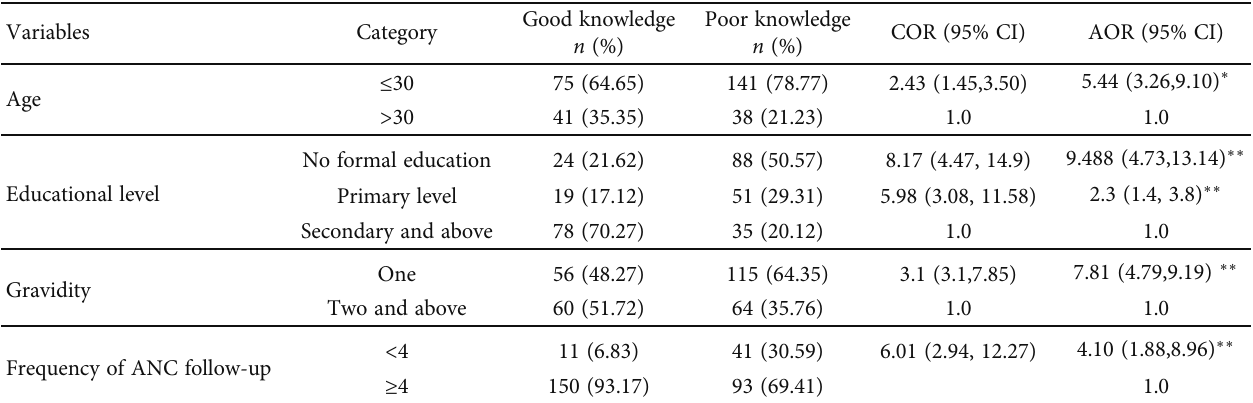
Table 6: Factors having an association with pregnant women ’ s knowledge on obstetric danger signs in Debre Tabor town, Northwest Ethiopia,